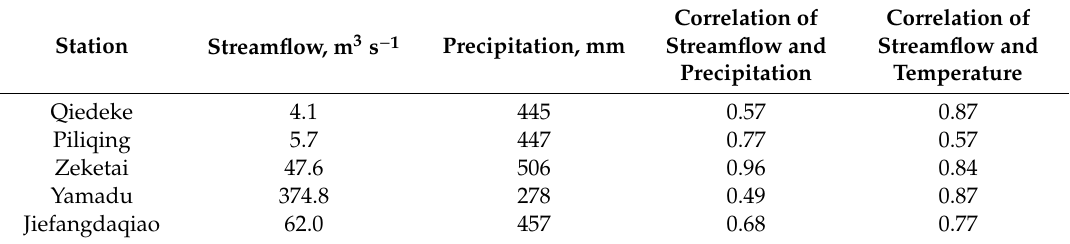
Figure 8. Precipitation (mm) and streamflow (m 3 s − 1 ) averaged over the 1960–2010 period for different stations. Locations of the stations are shown in Figure 1. Table 7. Mean annual streamflow, mean of annual sum of precipitation and Pearson correlation coefficient between monthly streamflow and monthly precipitation and temperature for the 1960–2010 period.